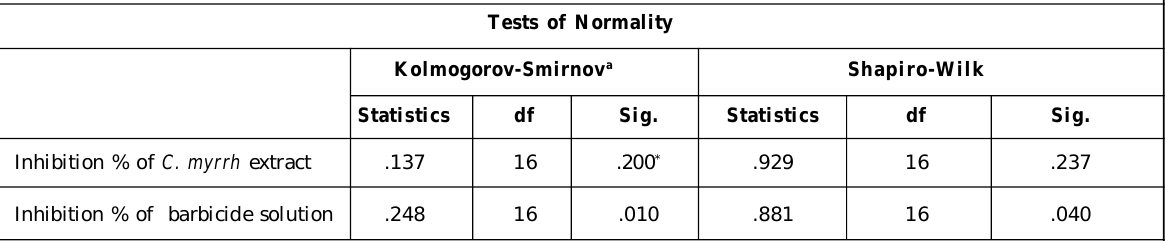
Table 9: Test the normality for the Inhibition % of C. myrrh extract and the Inhibition % of barbicide solution